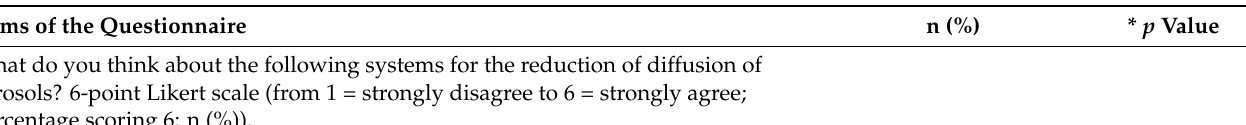
Table 3. Preferences in airway management in COVID-19